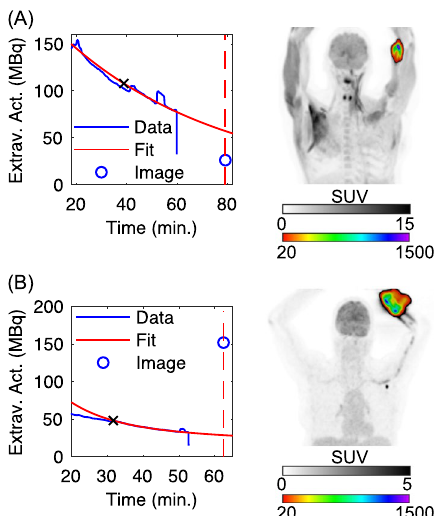
Fig. 6 Topical detector TACs and PET images for two outliers in the leave-one-out analysis. Subjects with ( A ) left antecubital fossa ( I TOT 26.3 MBq and ˆ D 4.1 kcps on Fig. 4A) and ( B ) left forearm ( I TOT = = ˆ D 3.2 kcps on Fig. 4A) injections, respectively. Topical detector TACs (“Data”) are scaled to total extravasation = activity to produce ˆ I TOT , using the matched leave-one-out calibration factor. Extrapolation fits (“Fit”) (fit starts denoted by x’s) and ground truth PET extravasation activities, I TOT (“Image”), are also displayed. Coronal maximum intensity projections are shown in two color scales to better visualize distribution of tracer extravasations